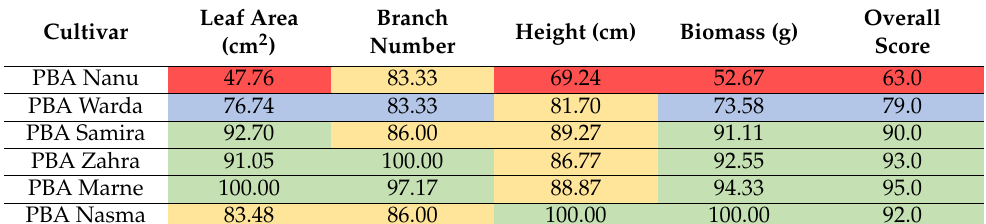
Table 9. Comparison of growth measures of different faba bean cultivars grown in Narrabri. For each trait, a percentage score and a colour code is assigned to each cultivar based on the relative value of trait attained. Cells are coloured to indicate likely competitiveness as follows <70 = red (poorly competitive), 71—80 = blue (moderately competitive), 81—90 = yellow (highly competitive), >90 = green (very highly